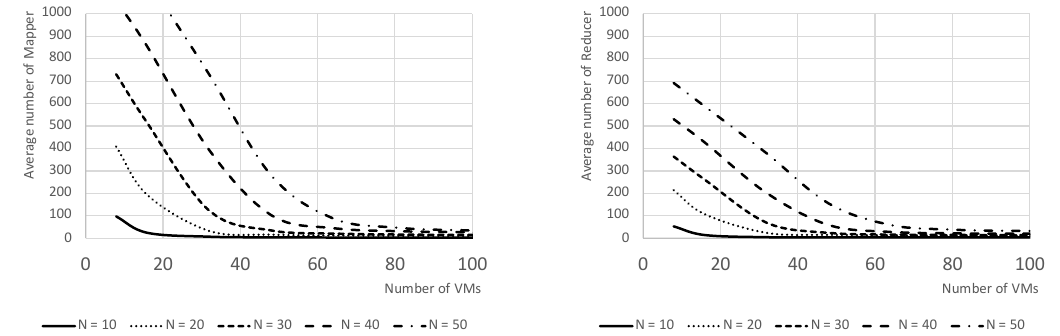
Figure 11. Average number of mappers ( left ) and reducers (right) for different number of users N and K